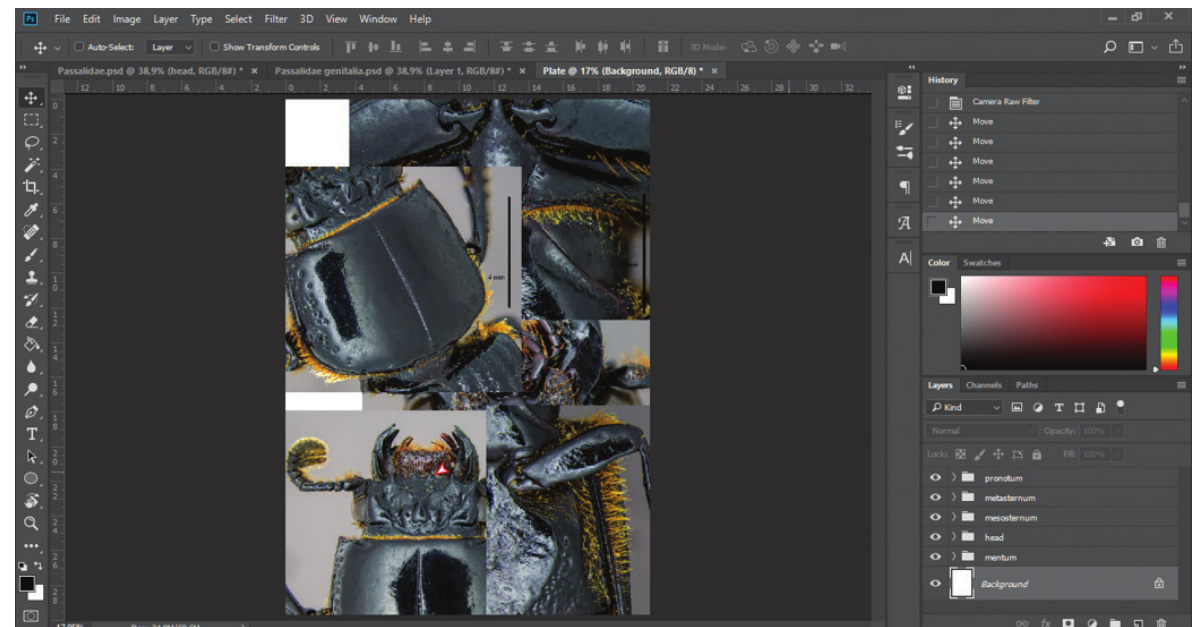
Figure 28. Window with new document containing images that will make up the